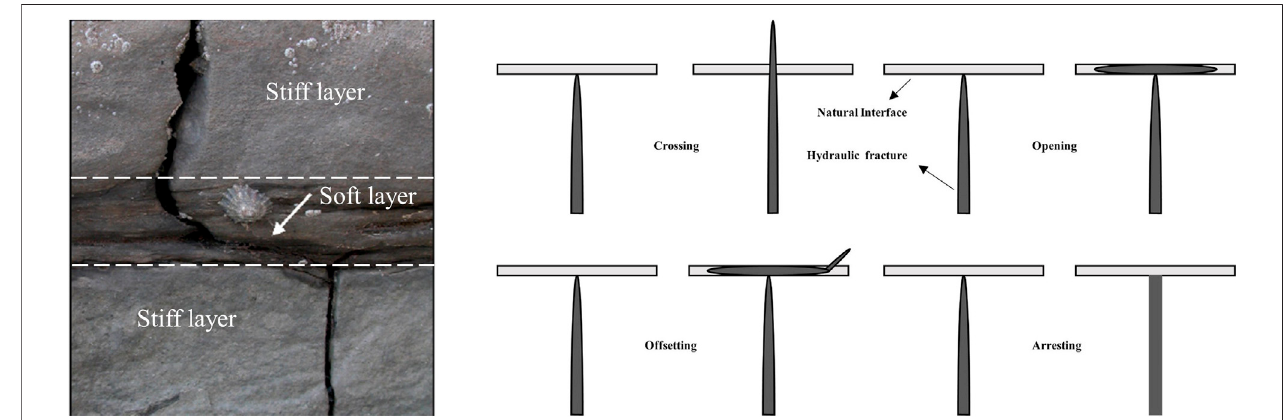
FIGURE 1 | (A) Hydraulic fracture propagation in the alternation of stiff and soft layers (Afsar, 2014). (B) Interaction modes between the hydraulic fracture and a natural interface (Sarmadivaleh, 2012).